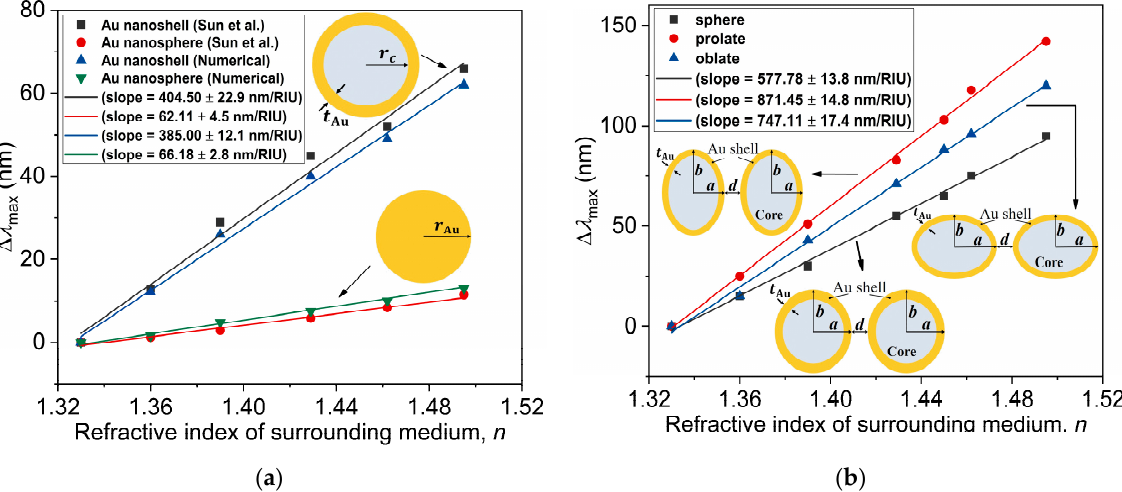
Figure 6. ( a ) Variations of the relative shift in the peak position (with respect to that for water, n = 1.33), ∆ λ max , with the refractive index of the surrounding medium for the Au nanoshell ( r c = 25 nm, t Au = 4.5 nm ) and solid Au nanosphere ( r Au = 25 nm ) , compared with the experimental study of Sun et al. [59]. ( b ) Variations of the relative shift in the peak position, ∆ λ max , with the refractive index for the spherical ( r = 20 nm, t Au = 3 nm ) and non-spherical ( r eff = 23 nm, η = 3 ) core-shell Au nanostructures. The straight lines in panels ( a ) and ( b ) represent the slopes of the data for the